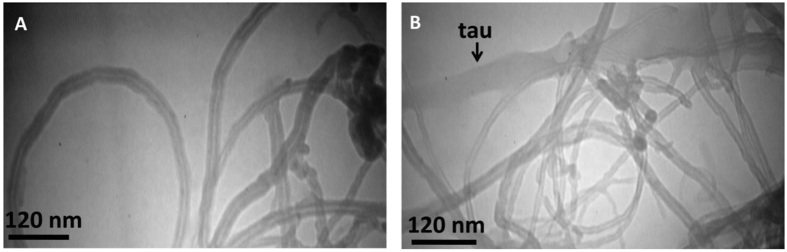
TEM observation.TEM image of MWCNT in the absence (A) and presence (B) of tau protein. MWCNT is susceptible to self-assembly in presence of tau protein and also tau protein has been aggregated upon titration of MWCNT.